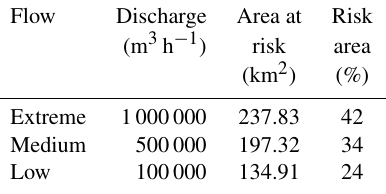
Table 2. Flood risk in Lagos